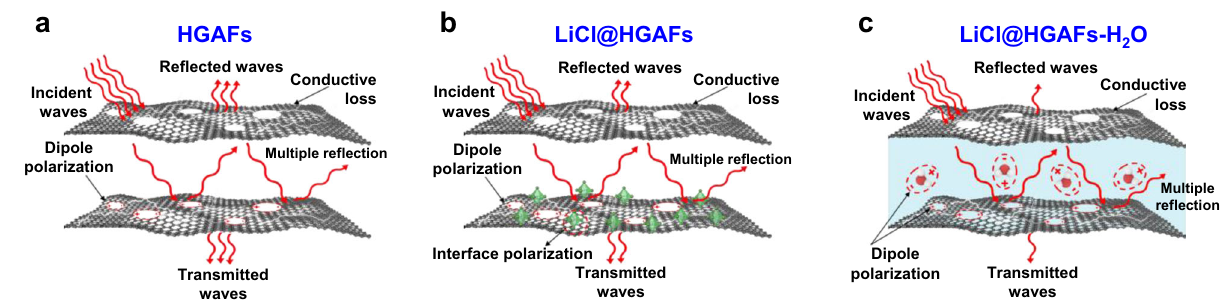
Fig. 6 Schematic diagram of the absorption mechanism. a HGAFs, b LiCl@HGAFs, and c LiCl@HGAFs-H 2 O. The blue-shaded region in panel c refers to the liquid water in the fi bers. The absorption mechanism mainly includes conductive loss, interface polarization, and dipole polarization. The incident wave will have multiple re fl ections in the material, and the above loss process will occur continuously. The dipole polarization process is greatly enhanced when water is present in